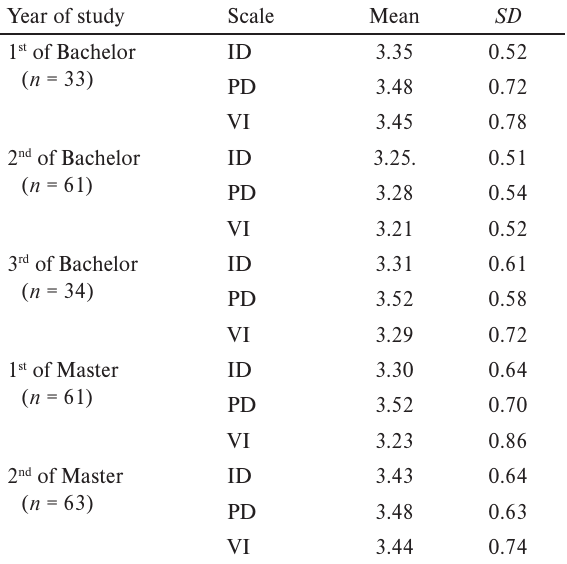
Mean scores for scales according to year of study Year of study